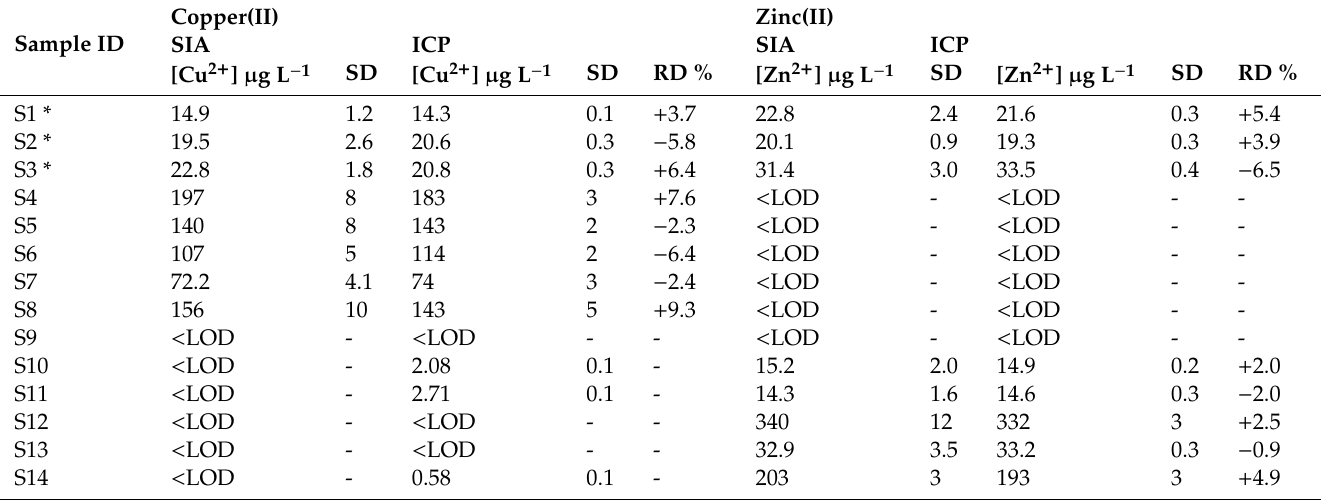
Table 3. Comparison of the results obtained with the newly developed SIA system for copper(II) and zinc(II) determination (three replicates) with those obtained